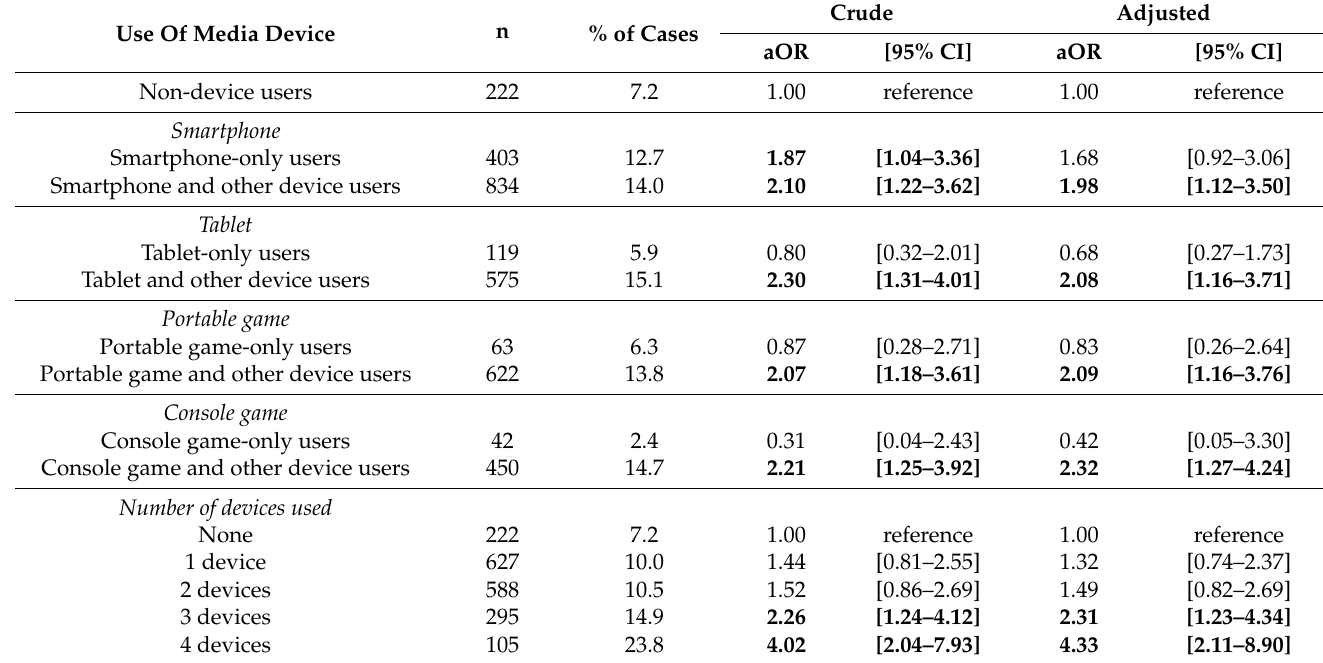
Table 2. Associations between children’s delayed bedtime (after 22:00 h) and use of media devices (N =